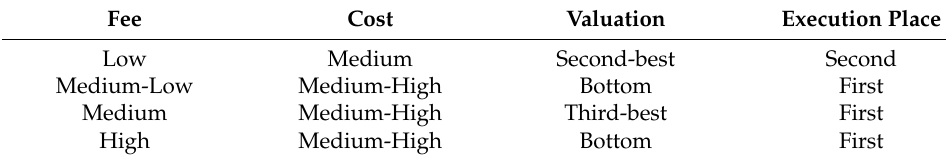
Table 5. Predicted execution time given the features of some contracts. Fee Cost Valuation